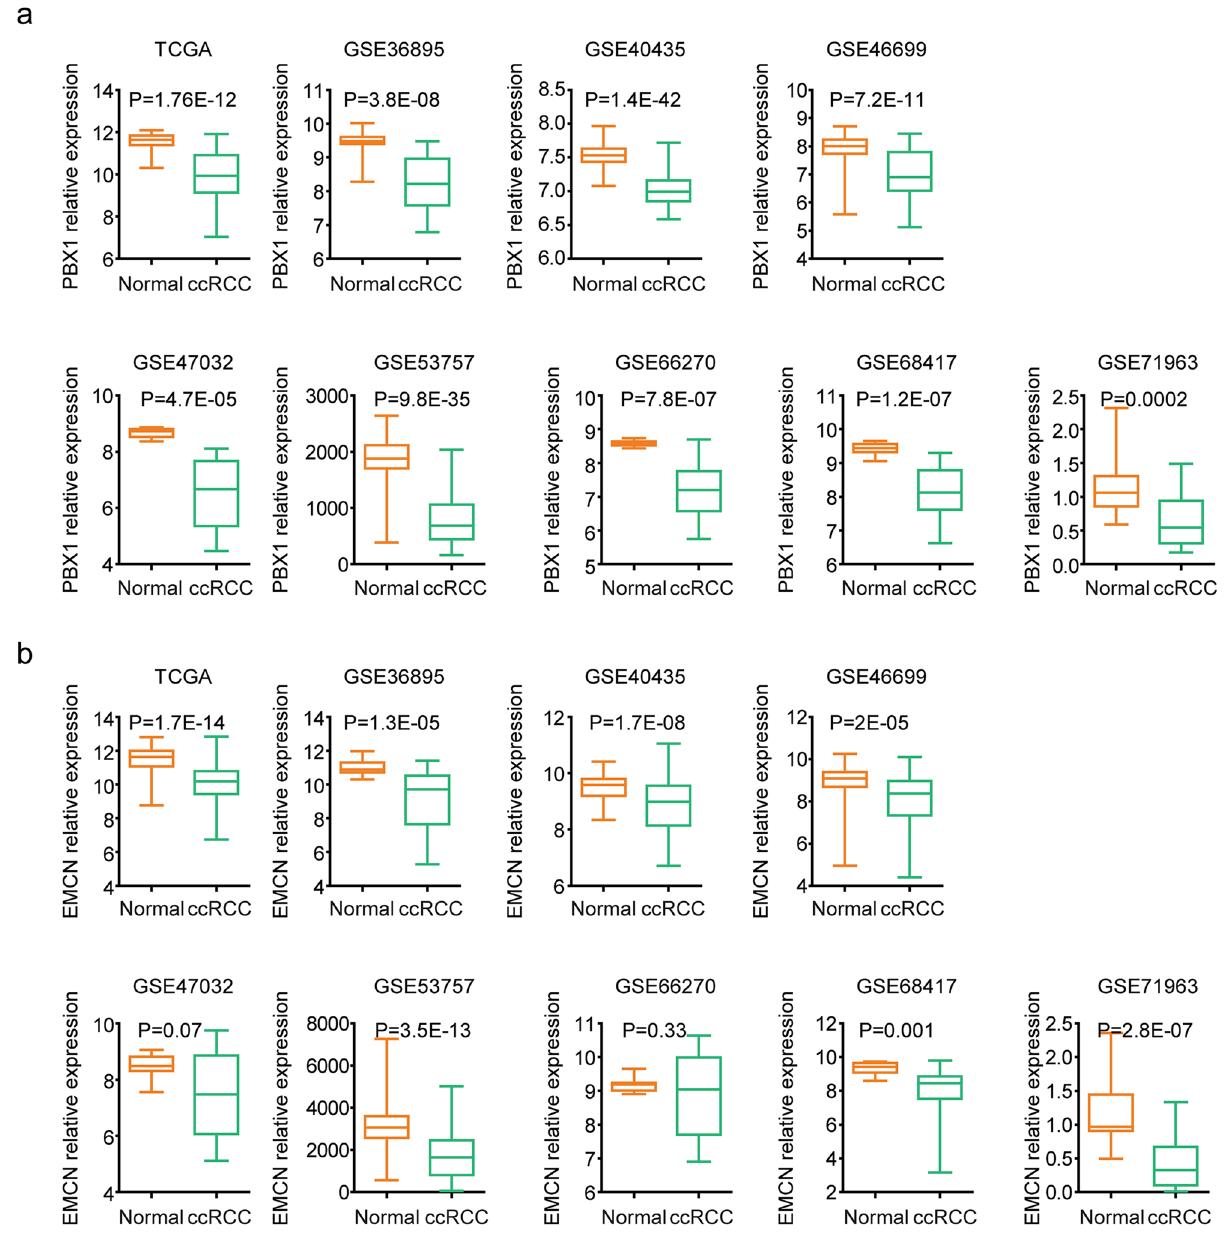
normal kidney and ccRCC tissues in TCGA and GEO